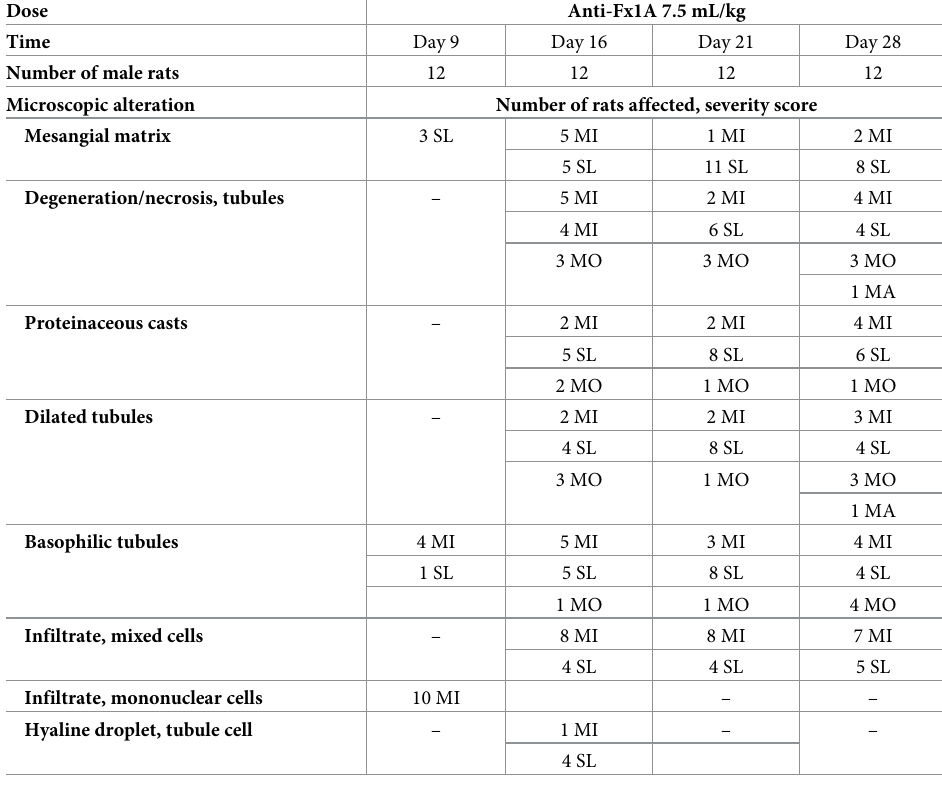
Table 3. Kidney microscopic alterations in anti-Fx1A-treated